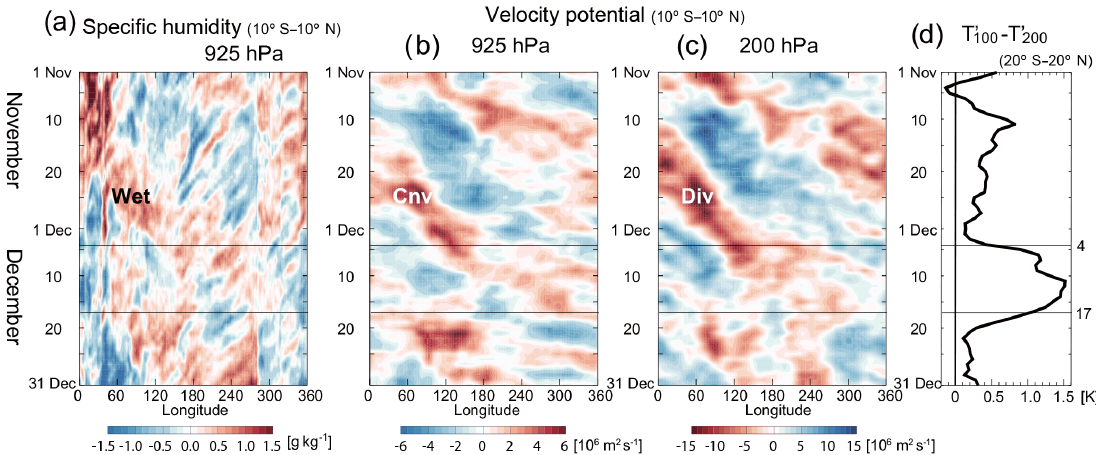
Figure 10. Time–longitude section around the equator (10 ◦ S–10 ◦ N) during November to December 2011 for (a) anomalous-specific hu- midity, (b) anomalous velocity potential at 925hPa, (c) anomalous velocity potential at 200hPa, and (d) difference in anomalous temperature between 100 and 200hPa. Time mean values during the analysed period are subtracted from climatological anomalies. “Wet”, “Cnv”, and “Div” indicate wet, convergent, and divergent zones respectively. Horizontal lines mark 4 and 17 December, similar to Fig.